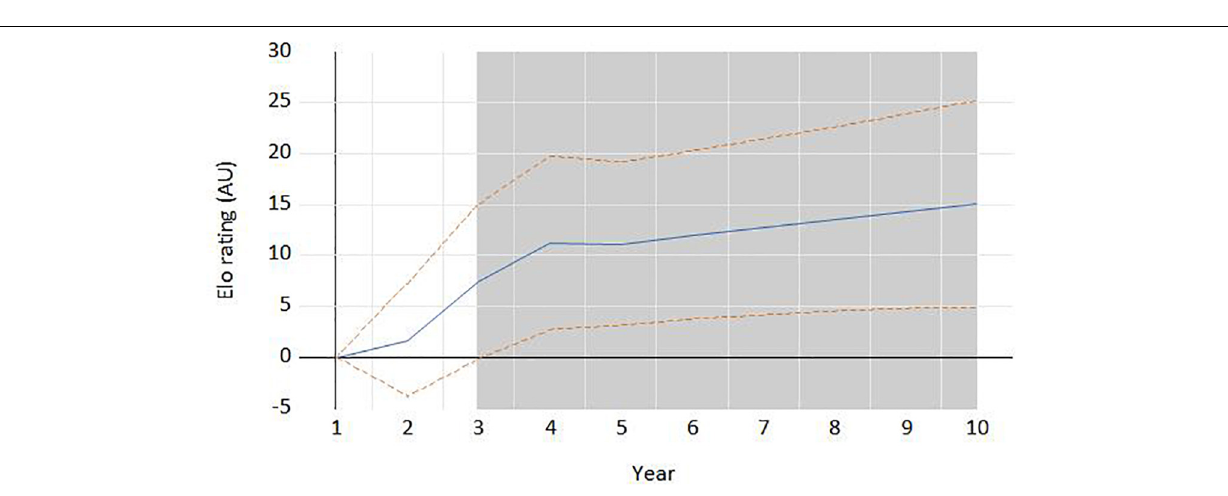
FIGURE 3 | Response of the ELO rating to an increase of 10 migrating players per country in year 1. The dotes lines are the whole plus/minus two standard error bands about the impulse responses is in positive ground. The shaded area in gray indicates statistical significance at 5% or